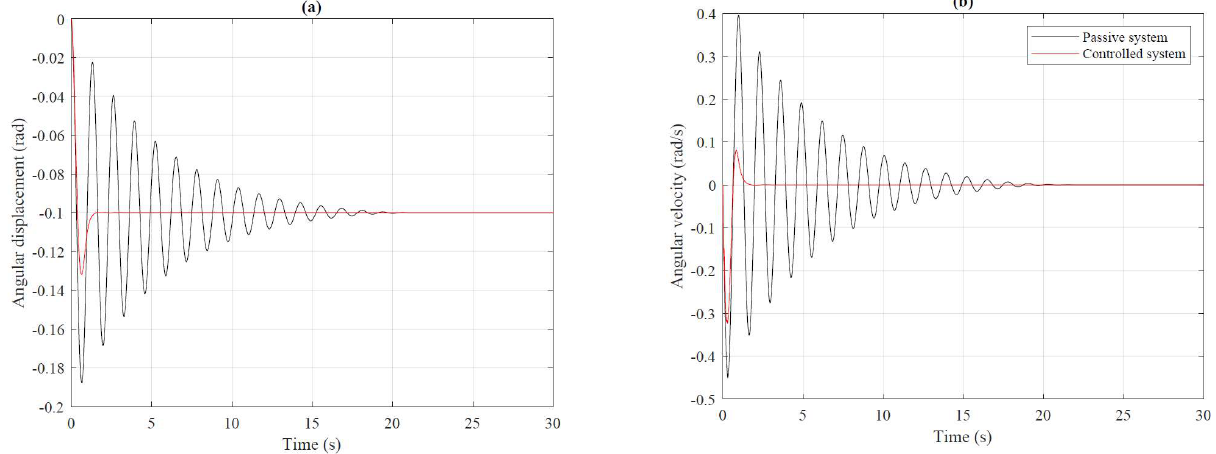
Figure 10. Angular displacement ( a ) and angular velocity ( b ) of the body along the longitudinal axis of the vehicle (roll). Table 2. The quality indicators of vertical acceleration of the vehicle body in the center of mass.